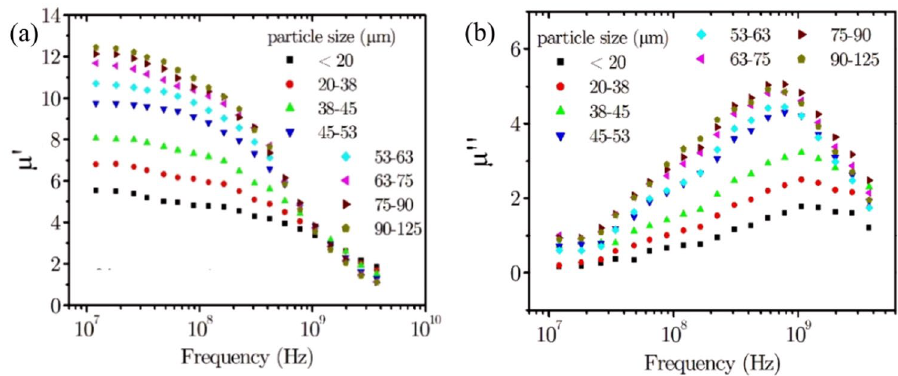
Figure 3. Plots of the complex relative permeability as a function of frequency for eight 70% vol. NiZn ferrite- PTFE composites containing different particle size ranges: ( a ) the real part of the relative permeability, while ( b ) the imaginary